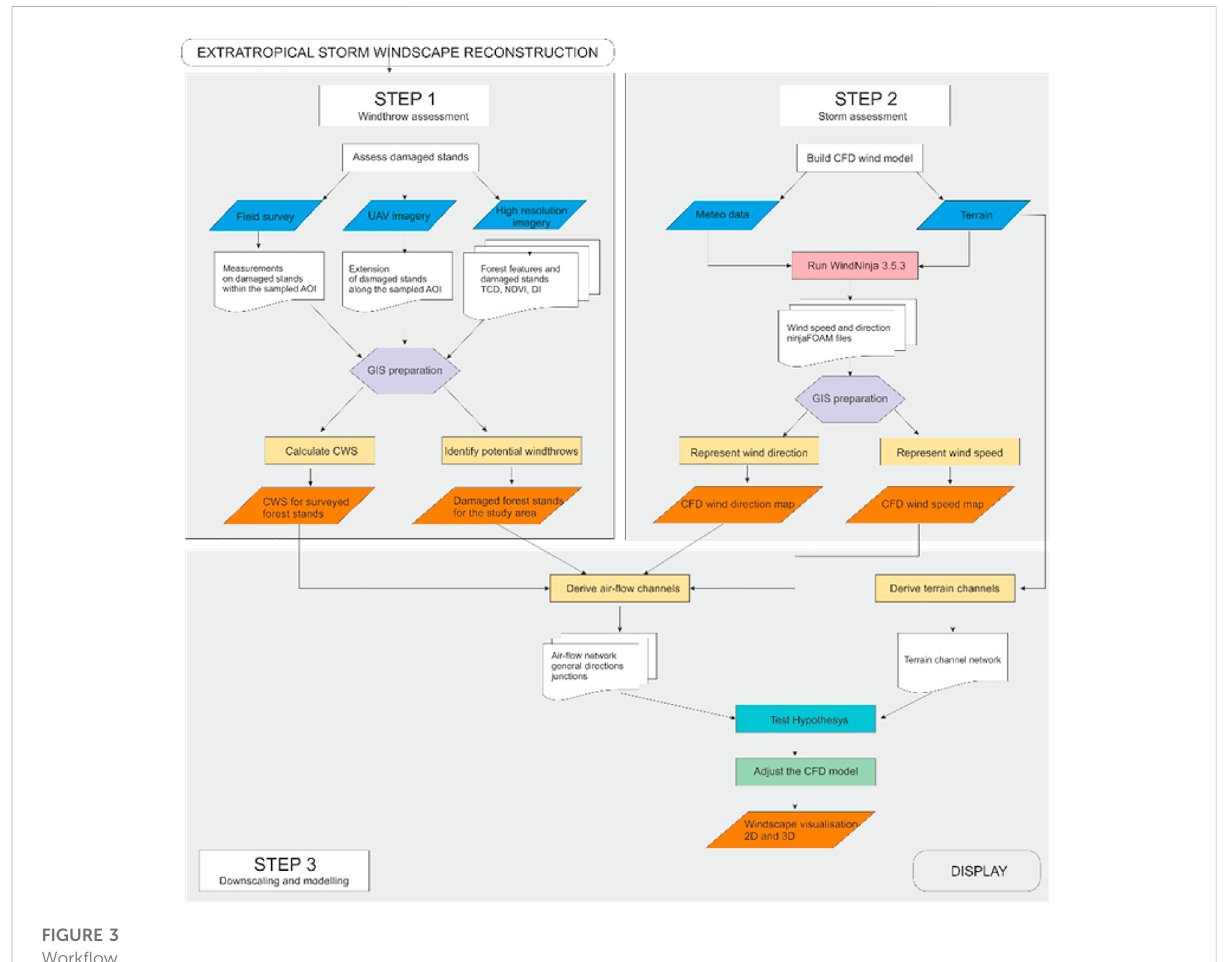
FIGURE 3 Work fl